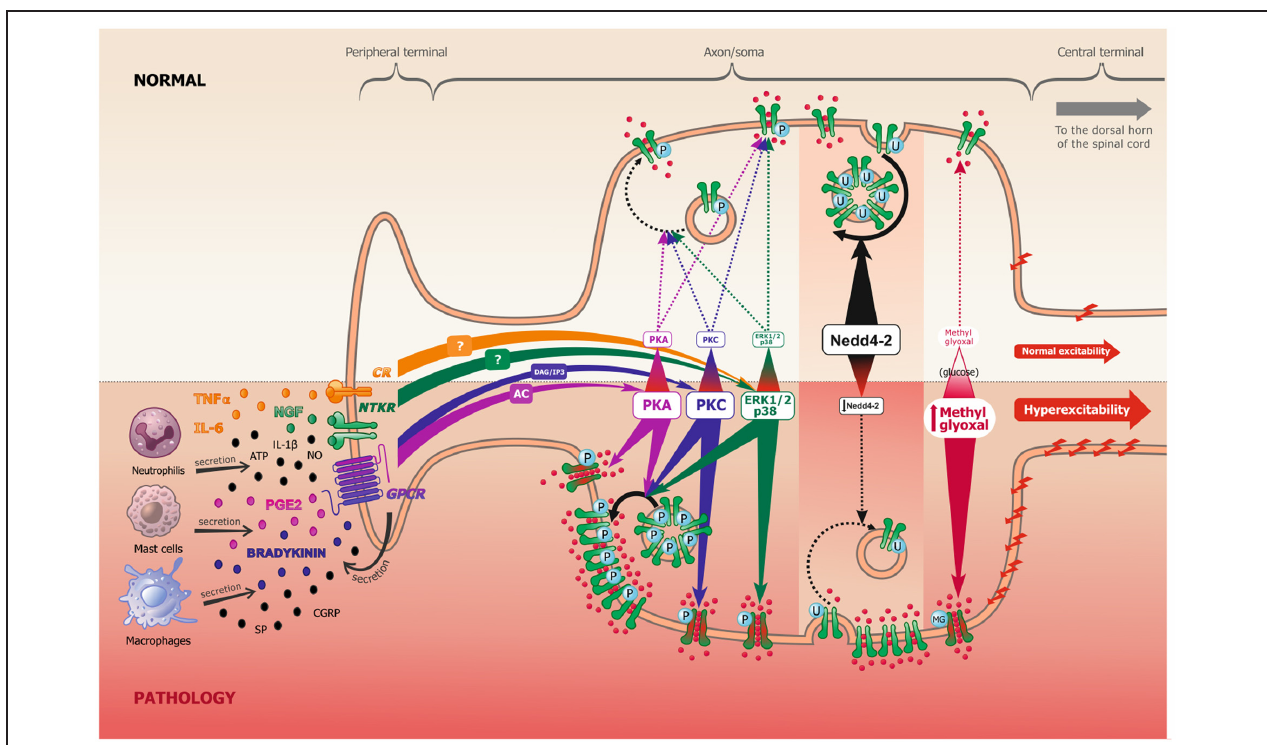
FIGURE 1 | Scheme representing the peripheral terminal, axon and cell soma of a pseudo-unipolar dorsal root ganglia nociceptive neuron, in normal and pathological pain conditions. Following tissue damage and inflammation, recruited inflammatory cells secrete numerous pro-inflammatory molecules (referred to as the inflammatory soup). These chemical mediators activate many membrane proteins, including G-protein coupled receptors (GPCR), neurotrophic tyrosine kinase receptors (NTKR) and cytokines receptors (CR). GPCR binding by PGE2 and bradykinin mostly leads to protein kinase A (PKA) and protein kinase C (PKC) activation, through the adenylate cyclase (AC) and inositol 3-phosphate (IP3) secondary messengers, respectively. NTKR and CR binding by TNF α , IL-6 and NGF will activate ERK1/2 and p38 kinases via different potential secondary messengers. These signal transduction pathways can undergo cross communication one with another. In experimental neuropathic pain, nerve injury induces Nedd4-2 downregulation. In models of diabetic neuropathy, as well as in patients, methylglyoxal accumulation is related to an increased glucose concentration. The increased activation of kinases, the downregulation of Nedd4-2 and the accumulation of methylglyoxal all lead to an increase of Na v 1.7/Na v 1.8 function (shift of biophysical properties, making the channel more available, as represented in green and red in the figure) and/or to an increase of Na v 1.7/Na v 1.8 expression at the membrane (altered trafficking), which leads to increased sodium influx and consequently to nociceptive neuronal